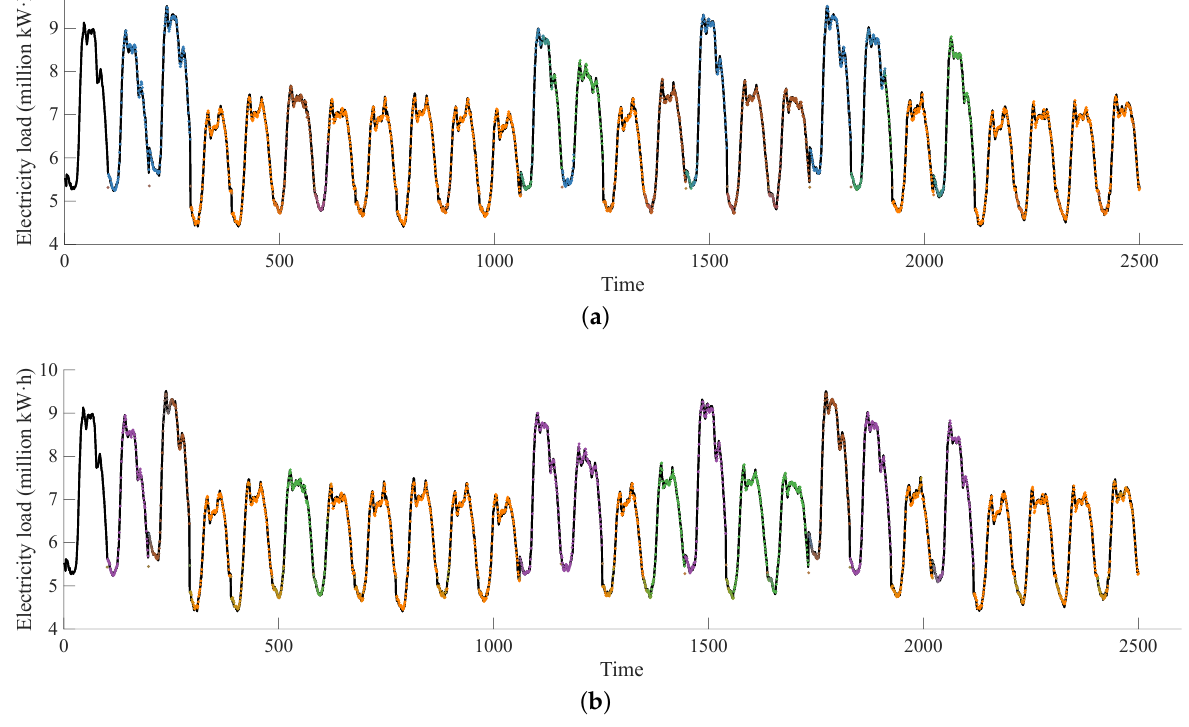
Figure 4. One-step-ahead rolling prediction results of HM-GPFR ( a ) and BHM-GPFR ( b